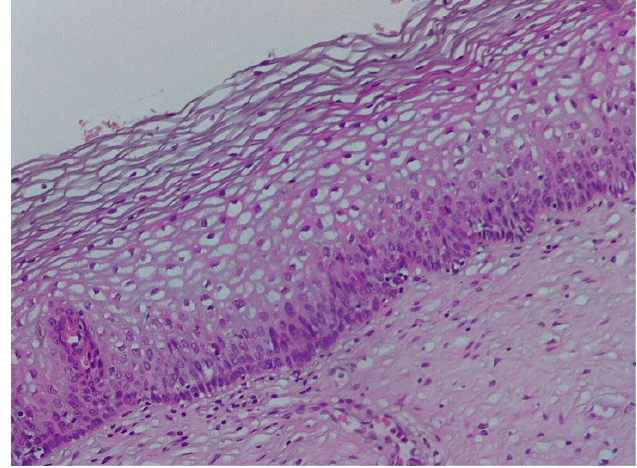
Figure 3. Histologic correspondent of the previous case—LSIL basal and parabasal cell proliferation, superficial epithelial thickening and acanthosis with frequent koilocytes in the intermediary layer (hematoxylin–eosin 10×).